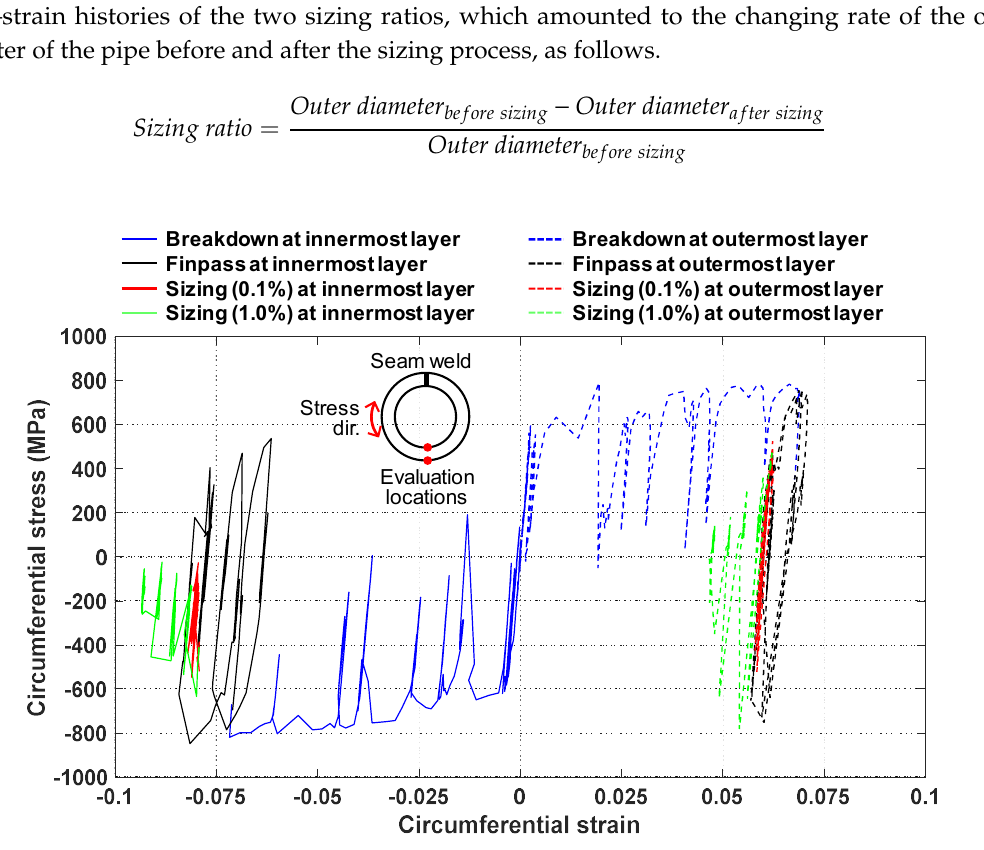
Figure 8. Strain history of each layer during the manufacture process.